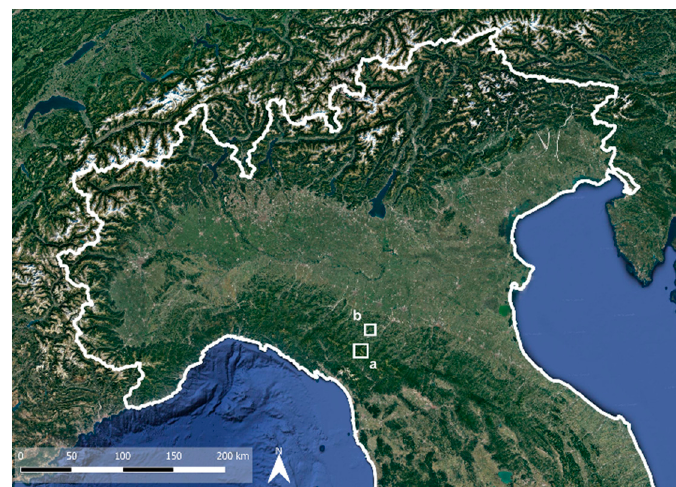
Figure 1. Google Earth ™ satellite image (Landsat / Copernicus 2020, seen on 30 July 2020) showing the location and general setting of the study areas: (a) Ozola River valley area; (b) Carpineti ridge area.